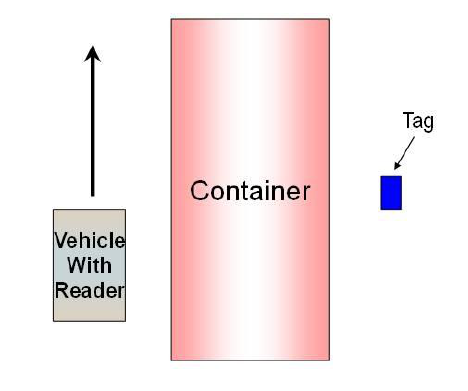
Figure 5. Setup of penetration test